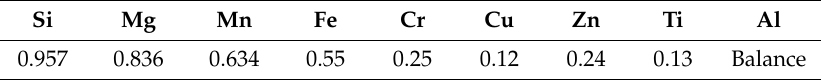
Table 1. Chemical compositions of the 6082-T6 aluminum alloy;